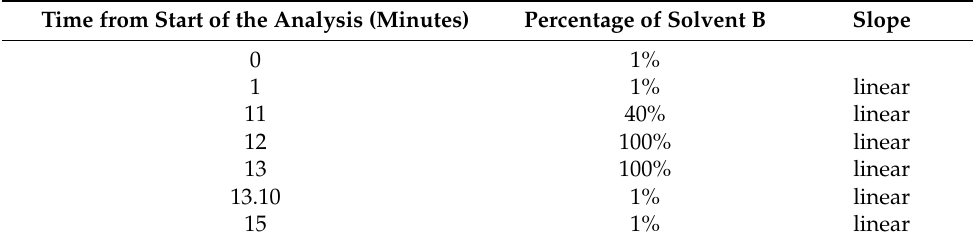
Table 1. Elution of the molecules in UPLC-DAD